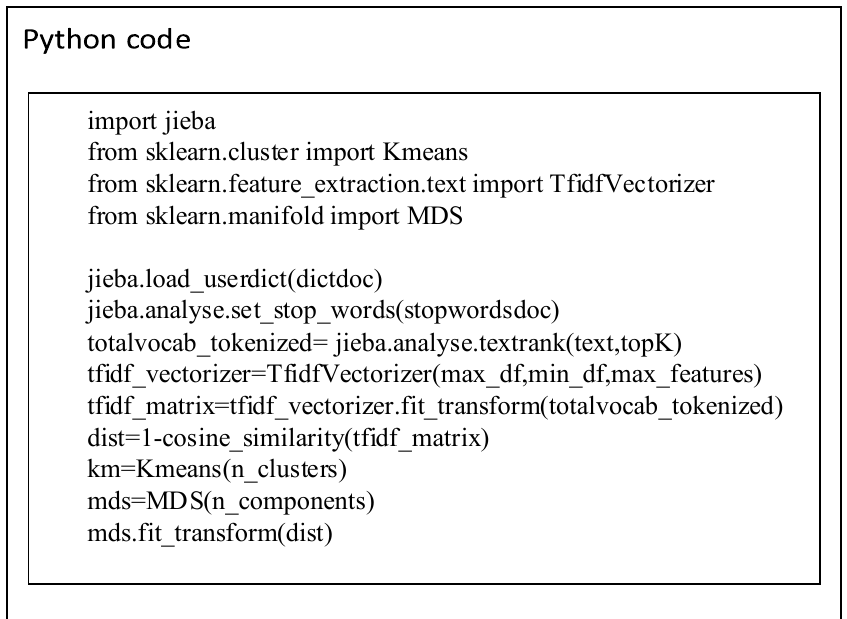
Figure 6. Python implementation code for natural language processing and K-means clustering.